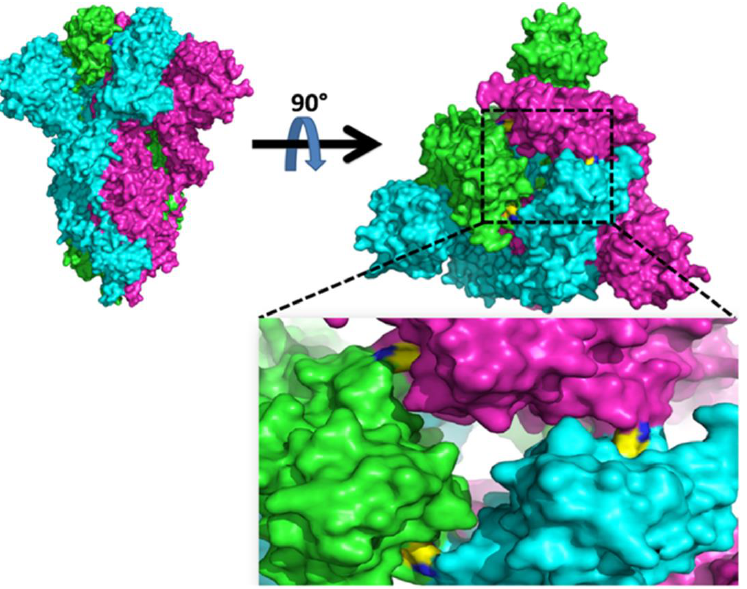
Figure 7. The spike glycoprotein in the trimeric state is shown as surface representation in the upper left. The protomer is shown in green, cyan, and magenta. The top view shows K417 interaction with N370 (between nearby protomers) shown as a yellow surface (upper right). The black dotted box zooms out to show the K417 and N370 interaction (below right).